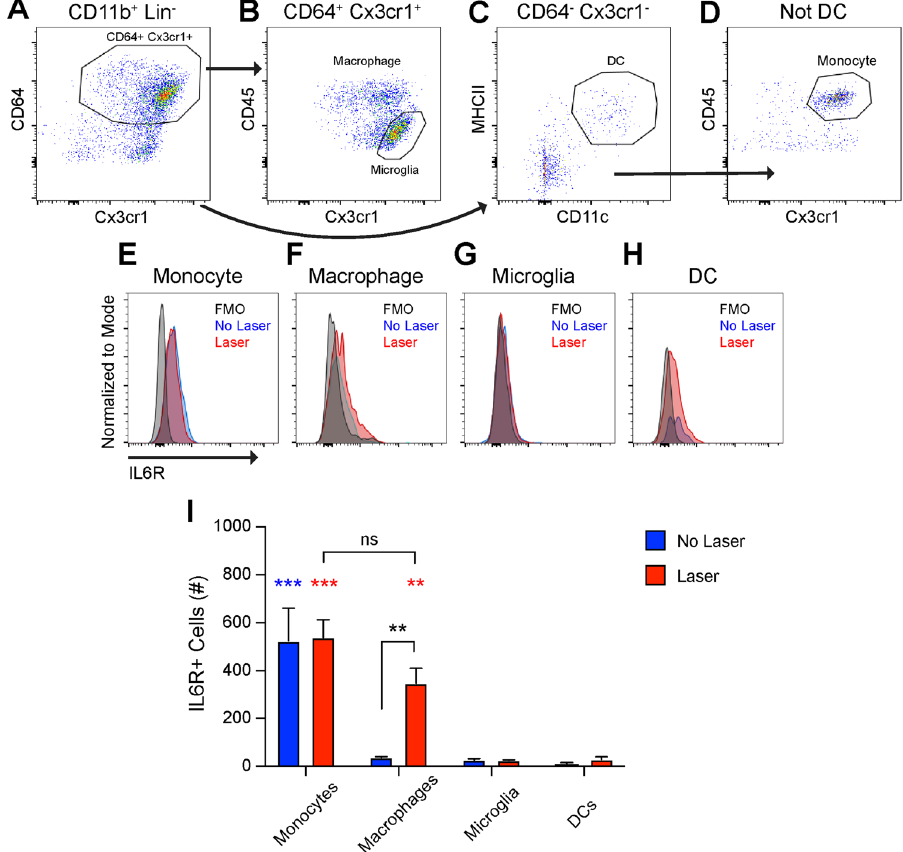
Figure 5. IL6R is expressed in ocular monocytes and macrophages. ( A ) CD64 + Cx3cr1 + cells were gated forward. ( B ) Microglia were defined as CD45 dim Cx3cr1 + while all other cells were determined to be macrophages (Boolean gate). ( C ) Non-Cx3cr1 + CD64 + cells were gated forward from (A) and dendritic cells (DC) were defined as MHCII + CD11c + . ( D ) Non-MHCII + CD11c + cells from (C) were gated forward and monocytes were defined as CD45 high Cx3cr1 + . E–H: Representative frequency histograms for IL6R expression from the fluorescence minus one (FMO) control, untreated (No Laser, Blue), and lasered (Laser, Red) mice in monocytes ( E ), macrophages ( F ), microglia ( G ), and dendritic cells (DC, H ). I: At steady state, monocytes expressed the IL6R. The number of IL6R + macrophages were increased by laser (** = p < 0.01, *** = p < 0.001, blue asterisks indicate differences from unlasered mice, red asterisks indicate differences from lasered mice, N = 3 per